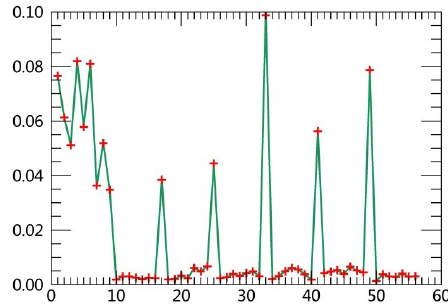
Figure 3. Weight line chart of 54 features in 2000.